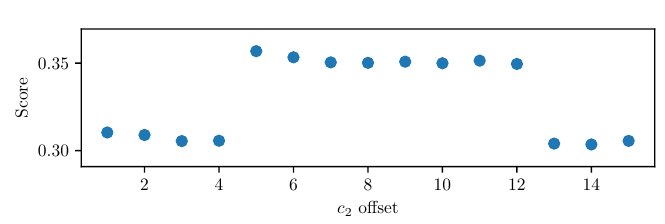
Figure 1: Values of the “collision score” obtained by adding “ c 2 offset” mod 2 T to one coefficient of c 2 (keeping the ciphertext the same on all other positions). Adding values between 5 and 12 lead to a decryption error, all other offsets do not. The two cases can be easily